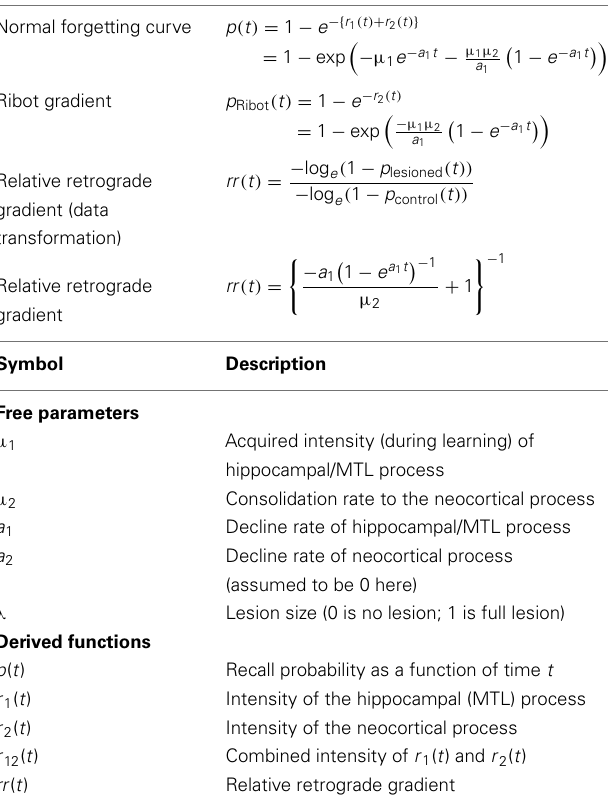
Table 1 | Overview of the equations and symbols used in this paper, assuming a 2 =